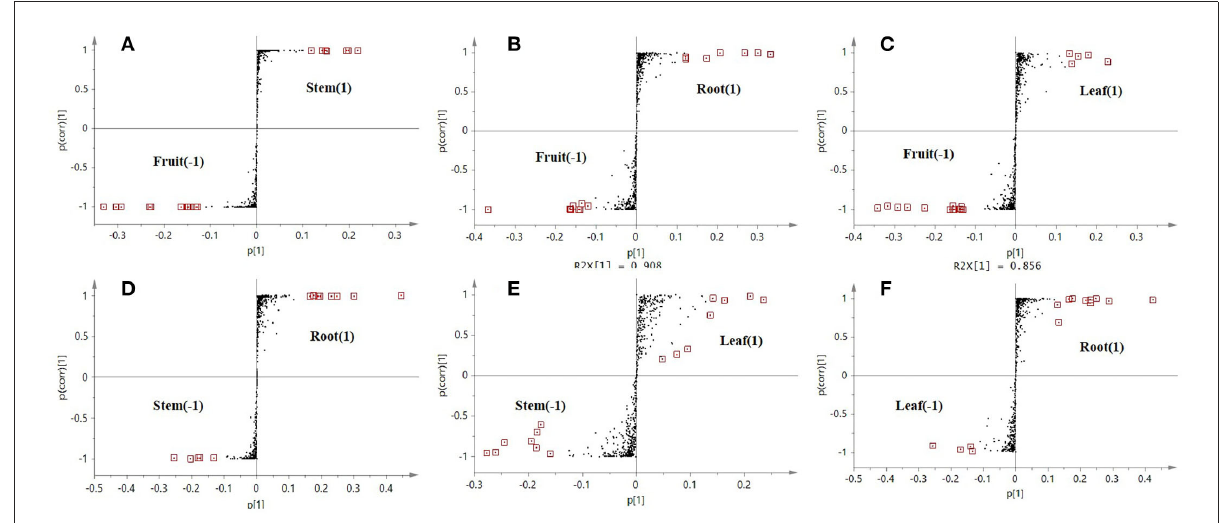
FIGURE4 S-plot score from the six different comparison models along with selected candidate marker compounds from each model (A–F) .